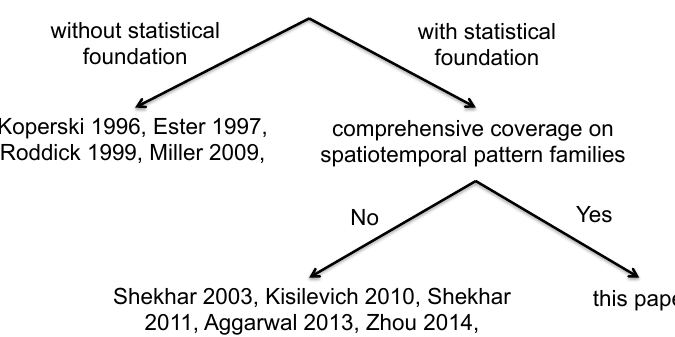
Figure 2. Categorization of spatial and spatiotemporal data mining